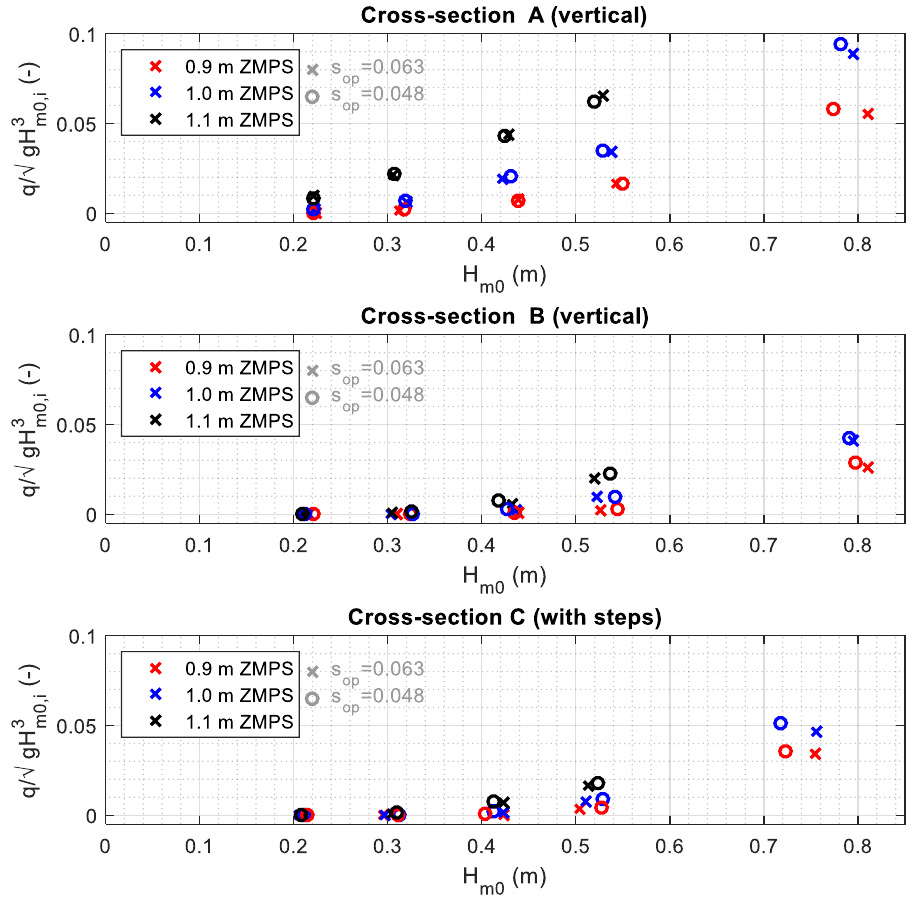
Figure 10. Wave overtopping results for the three tested cross-sections, from top to bottom: type A , type B and type C .